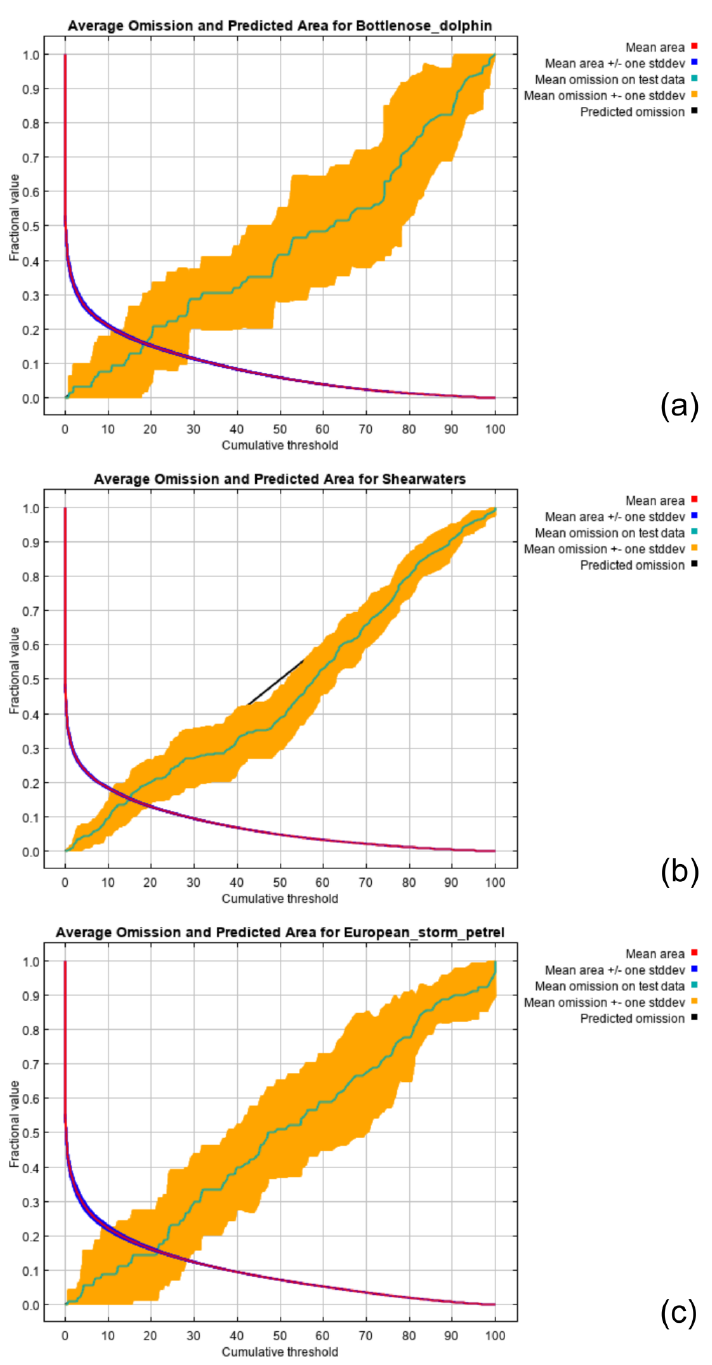
Figure 7. Resulting graphs from MaxEnt binomial test, showing the trend of the average omission rate and the predicted omission for ( a ) bottlenose dolphins, ( b ) shearwaters, and ( c ) European storm